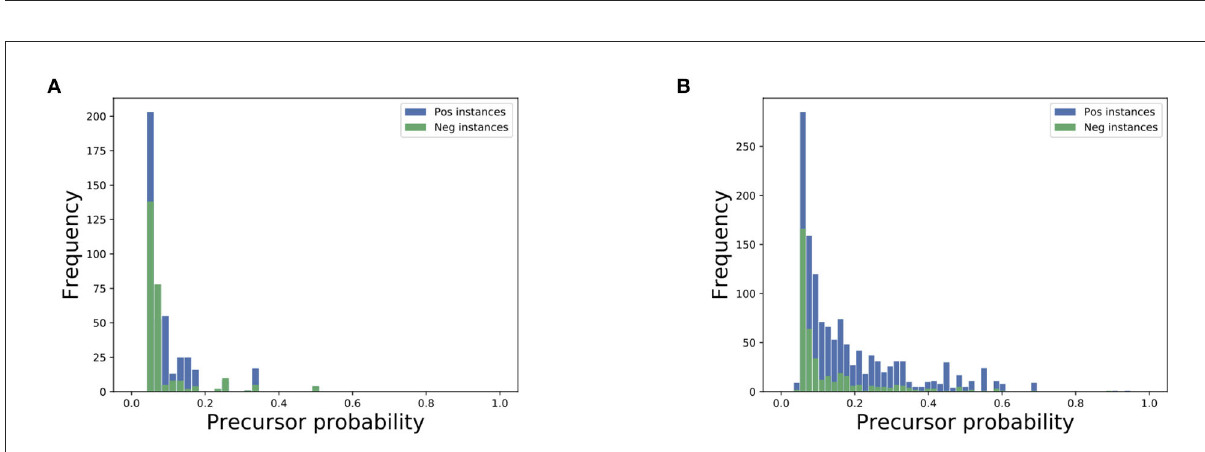
FIGURE5 Distribution of precursor probabilities for negative examples (green) and positive examples (blue) for the city of Ar Raqqah (A) and Brasilia (B)